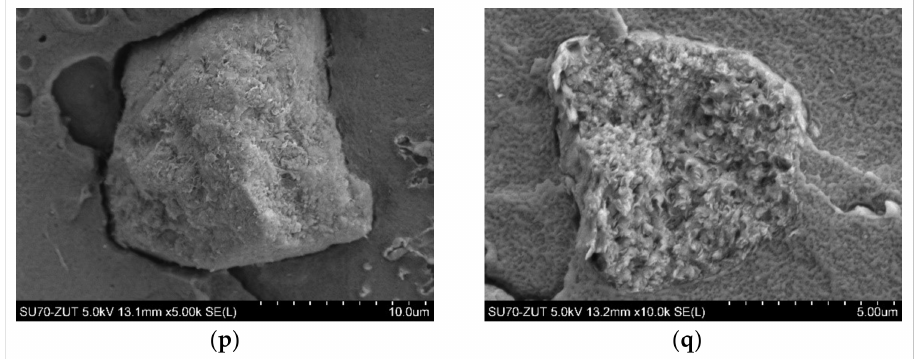
Figure 3. SEM micrographs: ( a ) PELS; ( b , c ) PELS 2.5% C20A; ( d , e ) PELS 5% C20A; ( f , g ) PELS 7% C20A; ( h , i ) PELS 5% C20A + HNT; ( j , k ) PELS 7% C20A + HNT; ( l , m ) PELS 2.5% HNT; ( n , o ) PELS 5% HNT; ( p , q ) PELS 7%